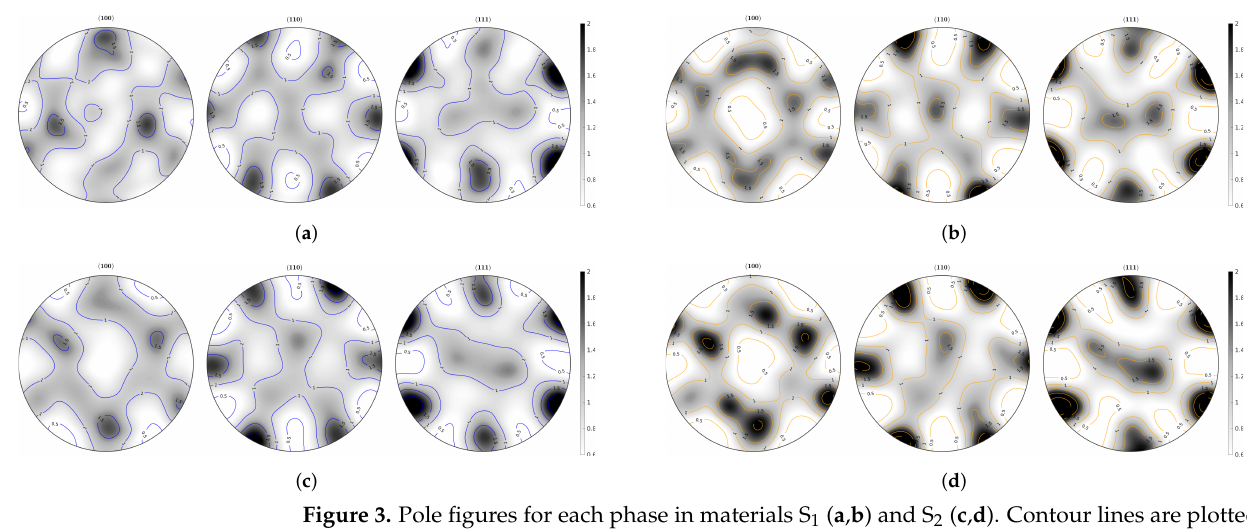
Figure 3. Pole figures for each phase in materials S 1 ( a , b ) and S 2 ( c , d ). Contour lines are plotted in blue for polygonal ferrite ( a , c ) and in orange for granular bainite ( b , d ). The white-to-black scale bar indicates the “multiples of random density”. Table 2. Micropillar compression test results grouped by slip plane families for materials S 1 and S 2